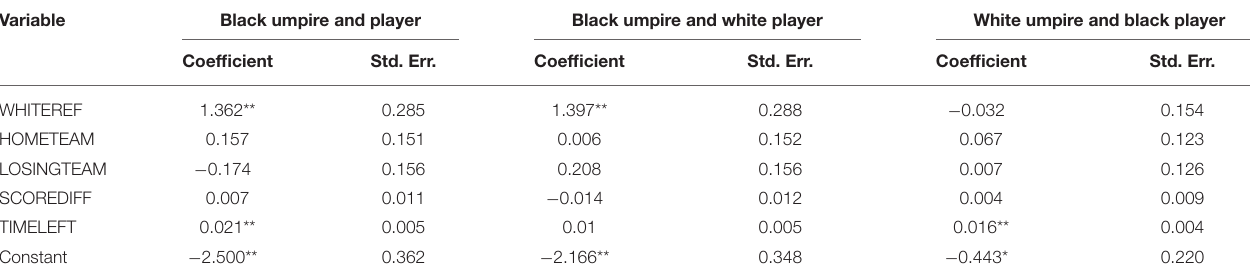
TABLE 3 | Player-level multinomial logistic regression. Variable Black umpire and player Black umpire and white player White umpire and black player Std. Err. Std. Err.